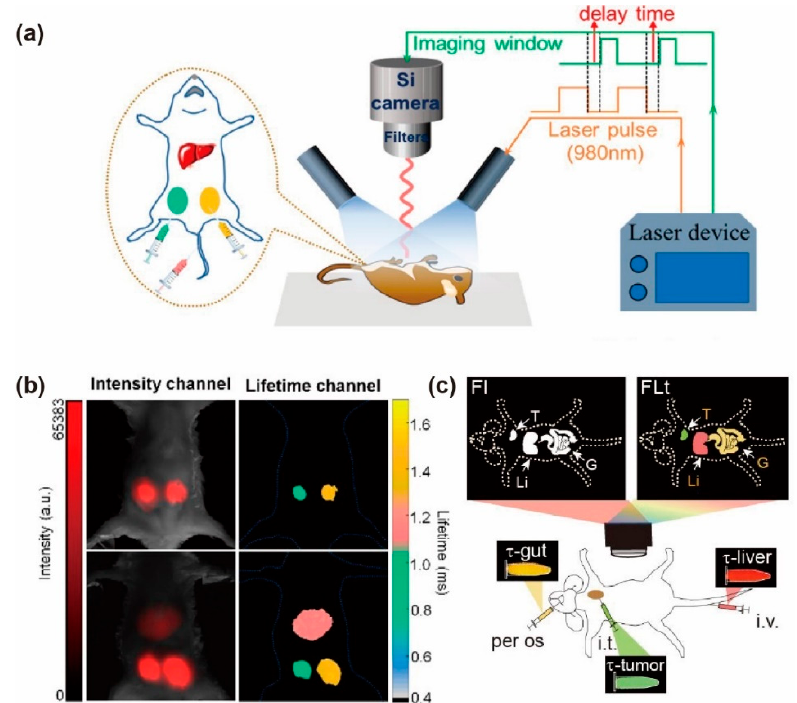
Figure 11. ( a ) Schematic diagram of nanoparticles with determined lifetime injecting into mouse, and then recorded by the home-built time-resolved luminescence imaging system. ( b ) The luminescence intensity (left) and lifetime (right) imaging of PAA-coated nanoparticles with two distinctive lifetimes injecting into a Kunming mouse and also into a second Kunming mouse (bottom). Reproduced with permission from [41]. Copyright 2020, American Chemical Society. ( c ) Schematic illustration of non-invasive NIR-II luminescence intensity and lifetime-based imaging for three diverse administration monitoring. Reproduced with permission from [87]. Copyright 2021, WILEY-VCH.